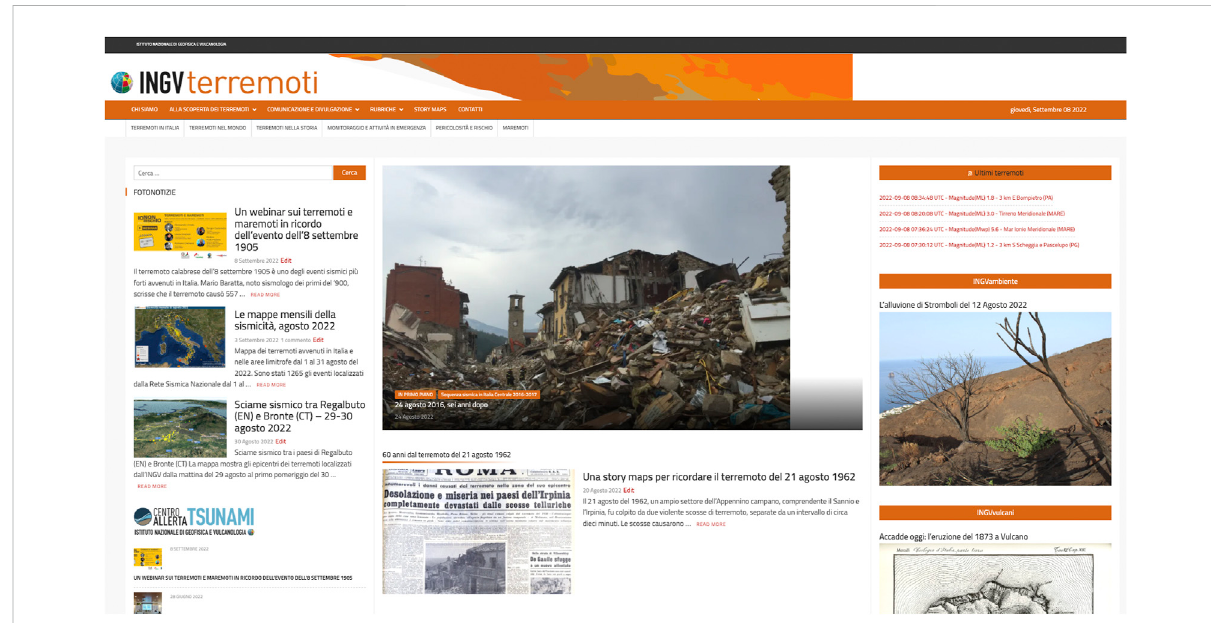
Home page of the blog-magazine INGVterremoti in 2022. The INGVterremoti blog menu re fl ects the new organization of static content and article